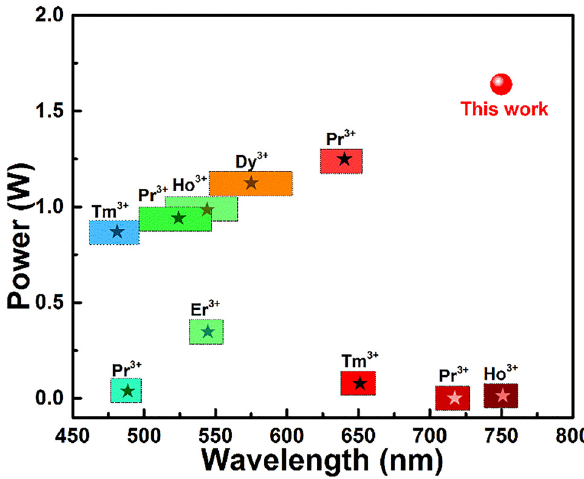
Figure 1: The output performances of visible fluoride glass fiber lasers reported to date [14, 18 –